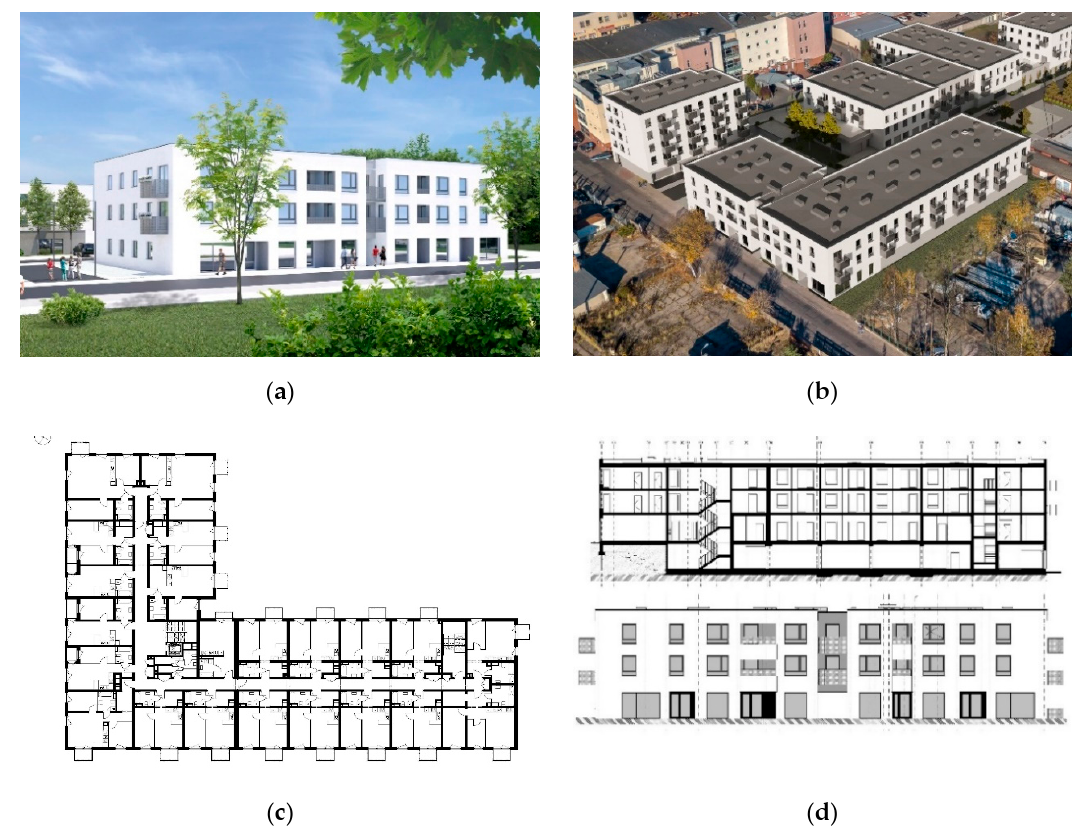
Figure 2. The building at Barnima Street in Stargard. ( a ) Visualization 01; ( b ) visualization 02; ( c ) floor plan; ( d ) cross section and east elevation.